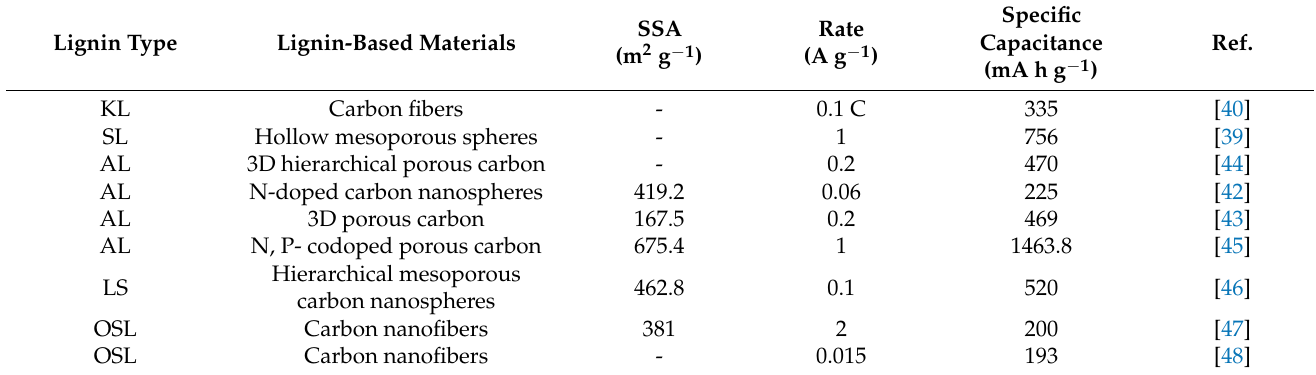
Table 2. List of applications of different industrial lignin-based electrodes for LIBs.